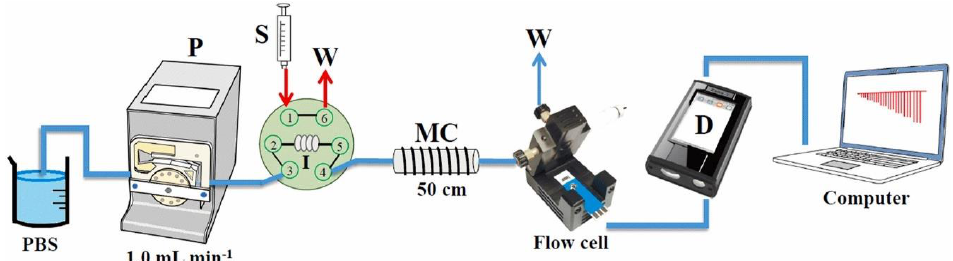
Figure 11. Illustration of FI-Amp system for uric acid determination using a CB-GO modified SPCE (PBS = 10 mM phosphate buffer pH 6.0, P = peristaltic pump, S = standard/sample, I = injection valve (150 μL), MC = mixing coil, W = waste, D = AC impedance electrochemical analyzer-simulator. Reprinted with permission from Elsevier from Ref. [149].